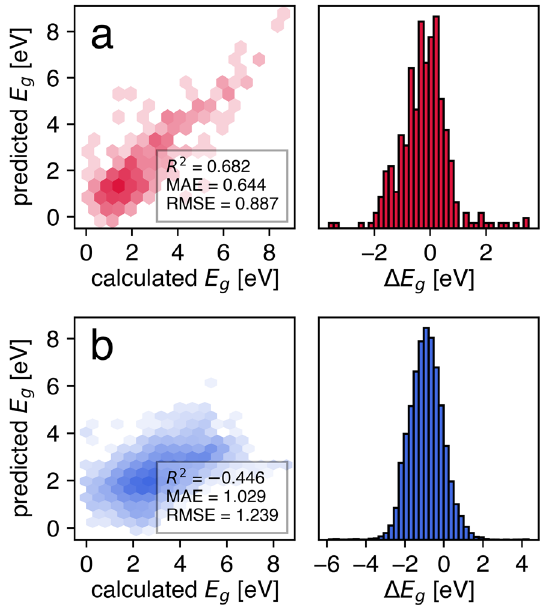
Figure 6. Parity plots and error histograms for the two considered out-of-domain use cases: ( a ) SNUMAT- MEGNet → C2DB-GPR-CFID, ( b ) QMOF-KRR-ElemStat → OMDB-RF-PLMF.